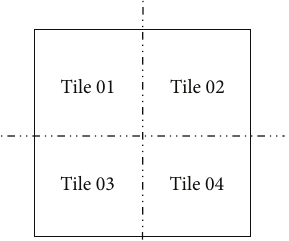
Figure 7: Dividing each block into four